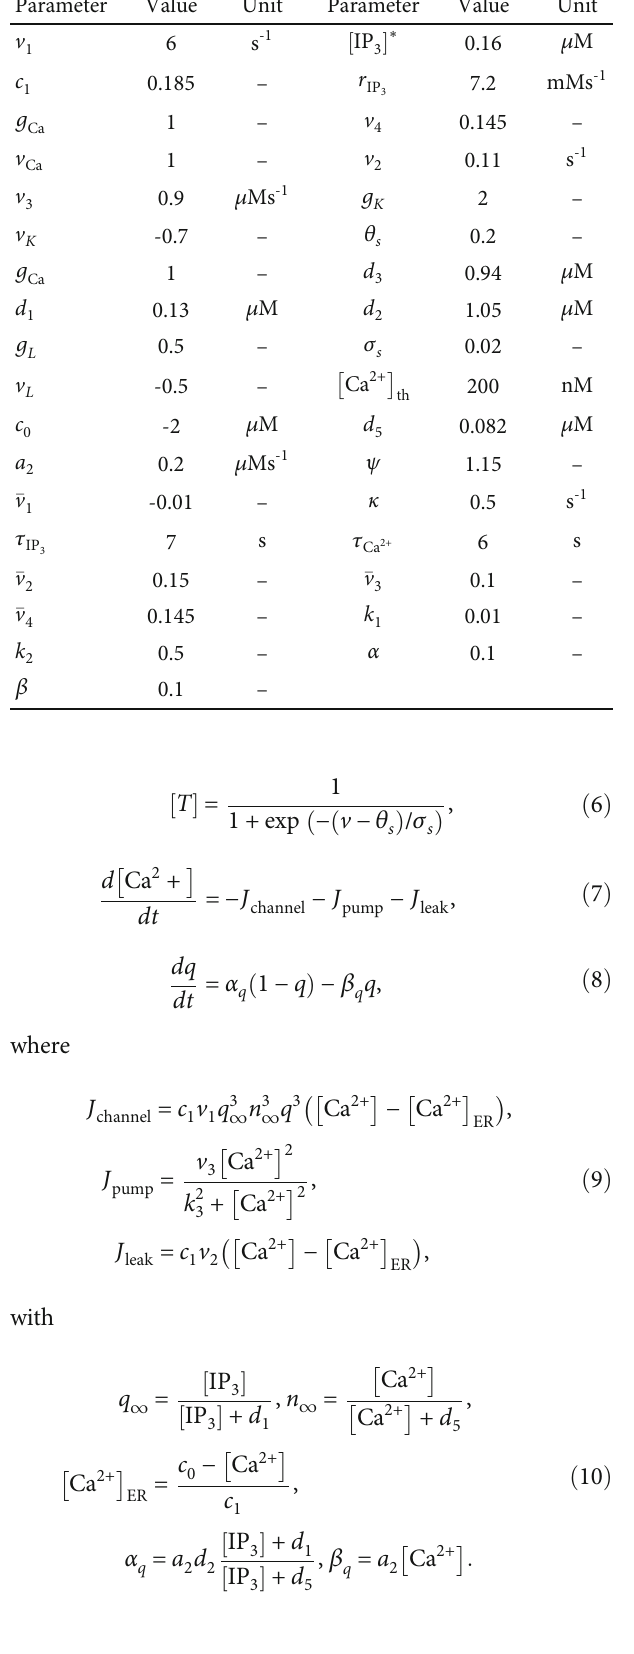
Table 1: Temperature and wildlife count in the three areas covered by the